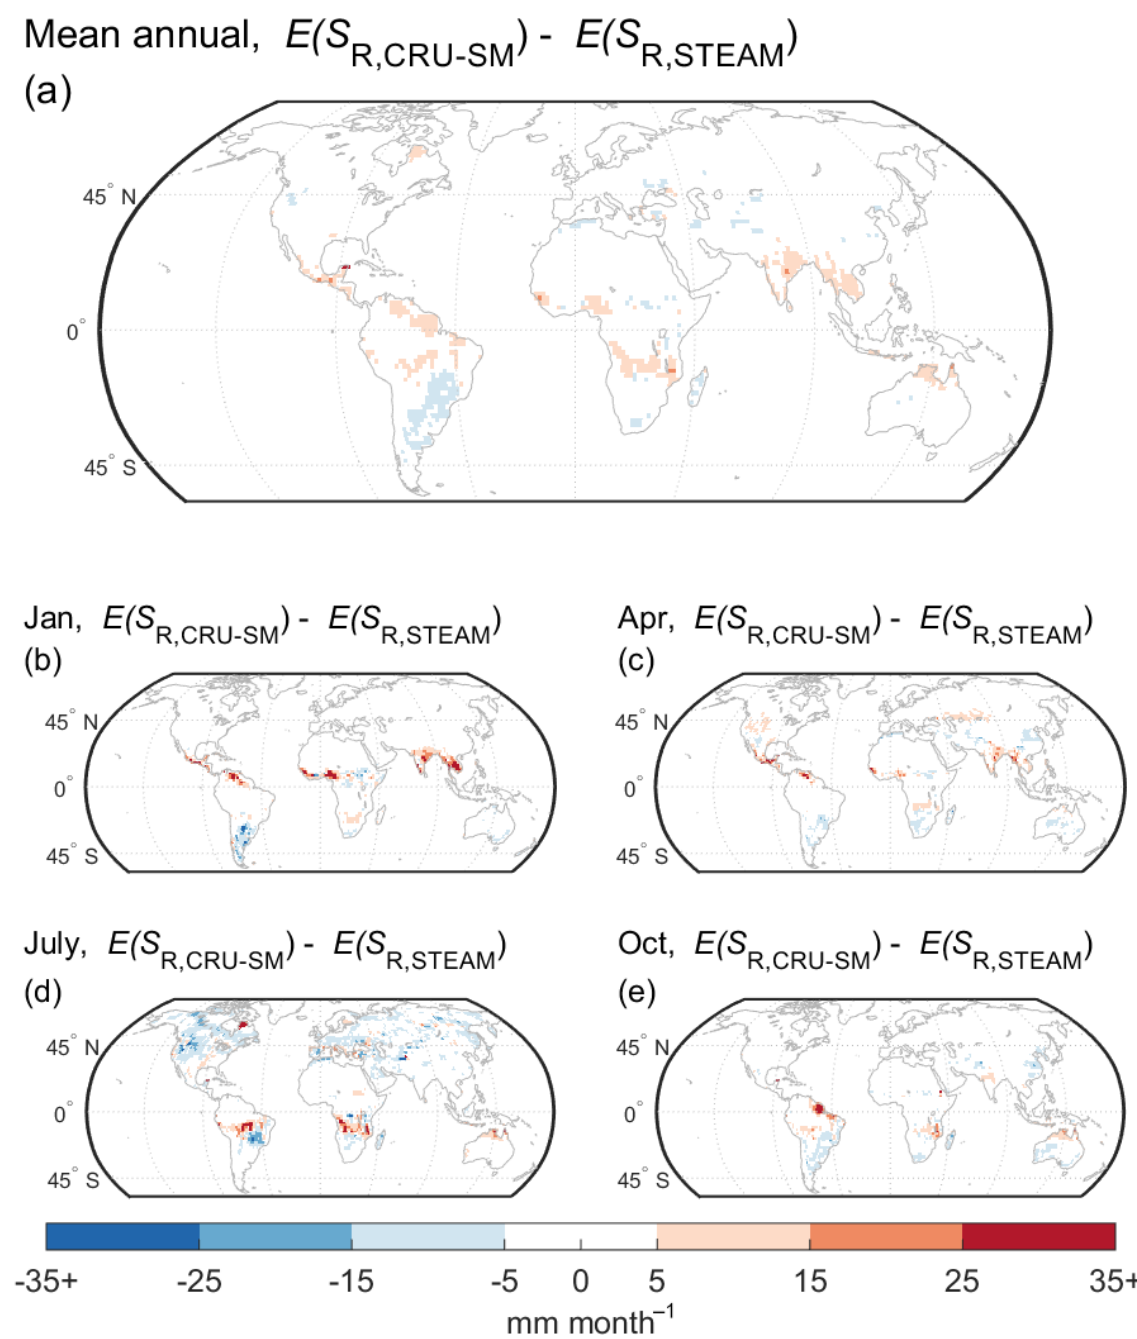
Figure 6. Difference in STEAM-simulated evaporation between using S R,CRU-SM (estimated based on E SM and P CRU in this study) and S R,STEAM (based on look-up table in Wang-Erlandsson et al., 2014) as root zone storage capacity parameterisation at (a) mean annual scale and averages for the months of (b) January, (c) April, (d) July, and (e) October over the time period 2003–2013. See also Sect.